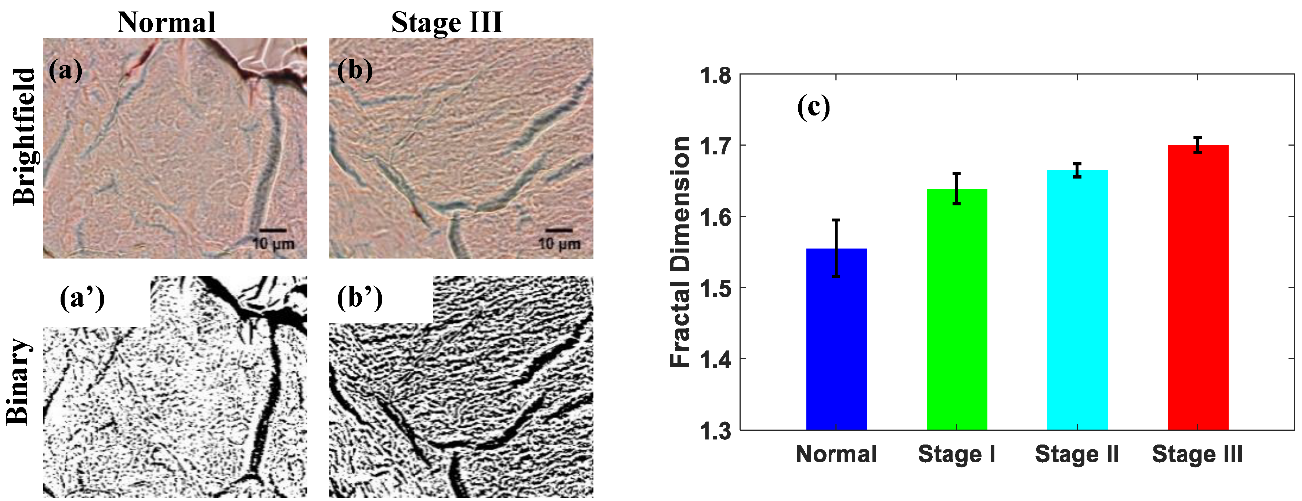
Figure 4. Colon cancer: ( a , b ) are the brightfield images of the normal and stage III Colon TMA. ( a’ , b’ ) are the corresponding binary images. ( c ) is the bar graph of the average fractal dimension of the Colon cancer tissue microarrays (TMA) samples (n = 24, 3–5 subjects per stage). The results show the fractal dimension of cancer stage I increases by 5%, stage II by 7%, and stage III by 9% with respect to the normal ( p -values < 0.05).